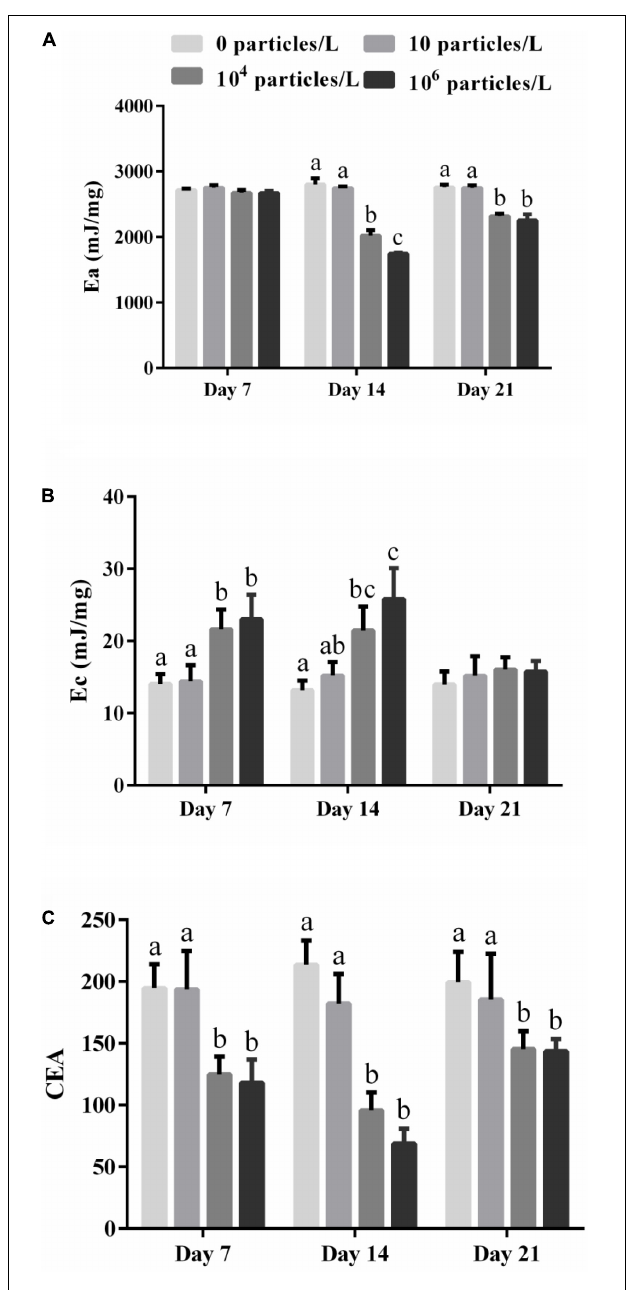
FIGURE 2 | The effects of exposure to different microplastics concentrations (0, 10, 10 4 , and 10 6 particles/L) on the parameters of cellular energy allocation (CEA) in the digestive gland of M. coruscus . (A) The available energy (E a ), (B) the energy consumption (E c ), (C) CEA. Different lowercase letters indicate that at the same sampling time point, there are significant differences between different microplastics concentration groups ( p < 0.05), and no letters indicate that at each sampling time point, there are no significant differences between different microplastic concentration groups ( p >